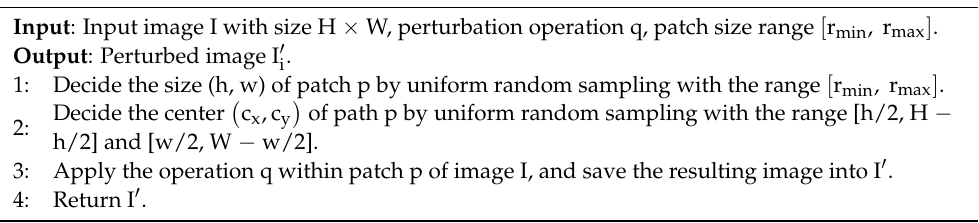
Algorithm 2. Image perturbation